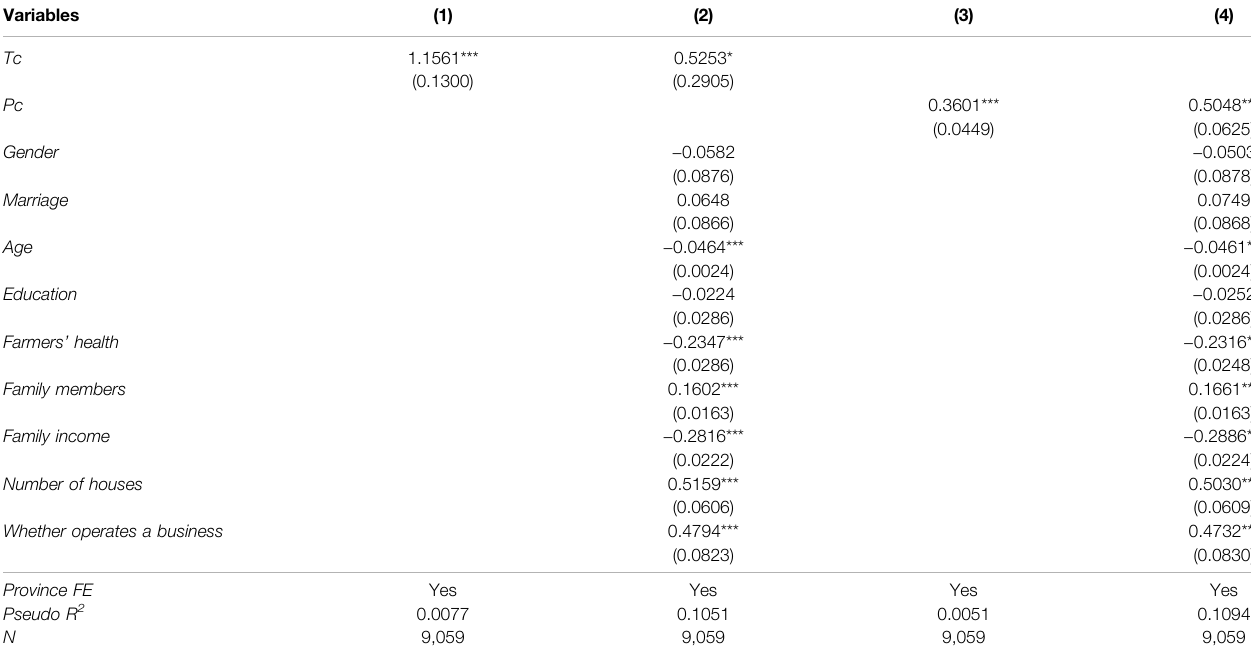
TABLE 2 | Baseline regression results.